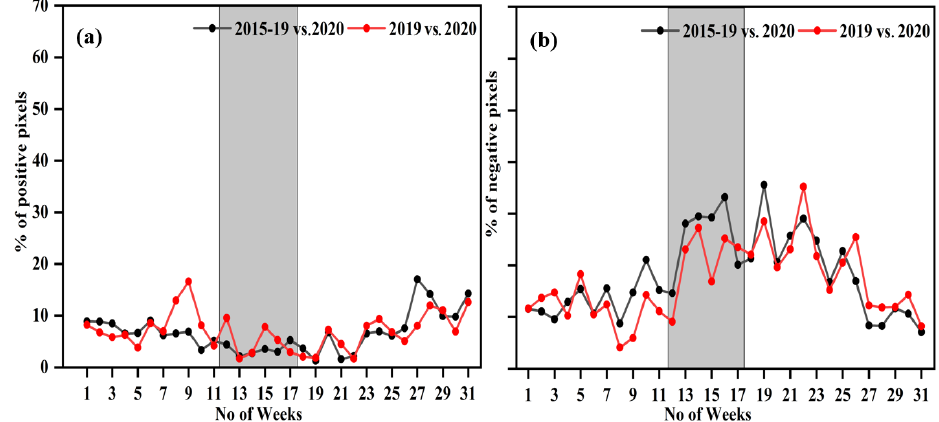
Figure 4. OMI measured the TCN (a) percentage of positive pixels and (b) percentage of negative pixels during the period 2020 vs. (2015– 2019) and 2020 vs.